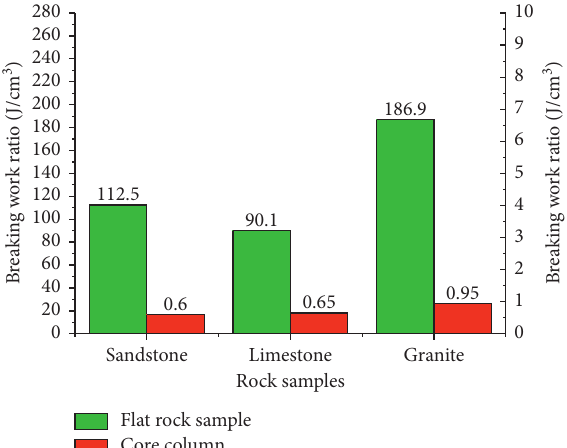
Figure 9: Breaking work ratio of flat rock samples and core columns in the static-pressure experiment.